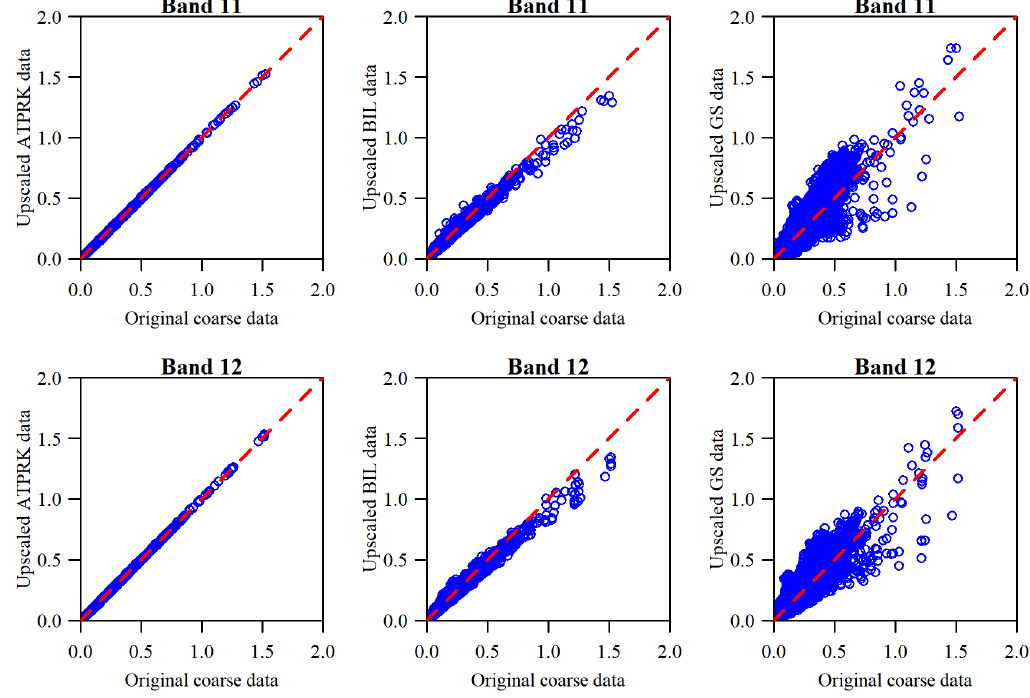
Figure 3. Preservation of spectral properties of the coarse SWIR bands for the ATPRK, BIL, and GS methods.